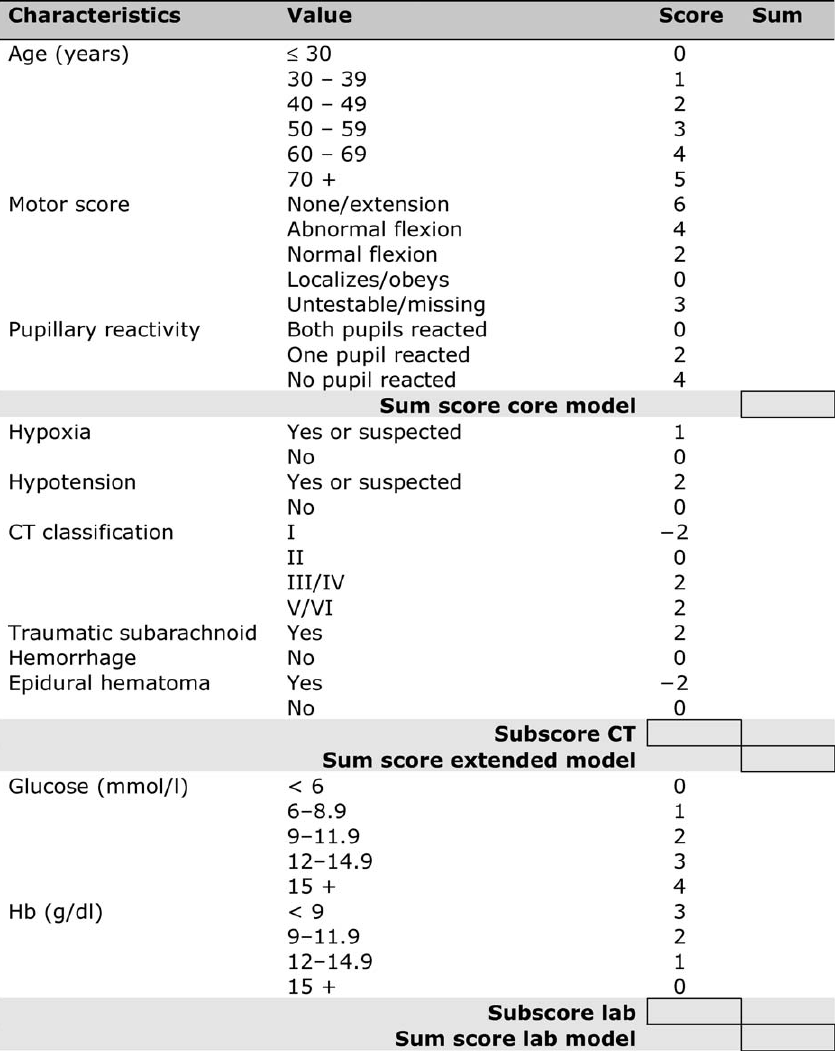
Figure 1. Score Chart for 6 Month Outcome after TBI Sum scores can be calculated for the core model (age, motor score, pupillary reactivity), the extended model (core þ hypoxia þ hypotension þ CT characteristics), and a lab model (core þ hypoxia þ hypotension þ CT þ glucose þ Hb). The probability of 6 mo outcome is defined as 1 / (1 þ e (cid:4) LP ), where LP refers to the linear predictor in a logistic regression model. Six LPs were defined as follows: LP core, mortality ¼(cid:4) 2.55 þ 0.275 3 sum score core LP core, unfavorable outcome ¼(cid:4) 1.62 þ 0.299 3 sum score core LP extended, mortality ¼(cid:4) 2.98 þ 0.256 3 (sum score core þ subscore CT) LP extended, unfavorable outcome ¼(cid:4) 2.10 þ 0.276 3 (sum score core þ subscore CT) LP lab, mortality ¼(cid:4) 3.42 þ 0.216 3 (sum score core þ subscore CT þ subscore lab) LP lab, unfavorable outcome ¼(cid:4) 2.82 þ 0.257 3 (sum score core þ subscore CT þ subscore lab) The logistic functions are plotted with 95% confidence intervals in Figure 2.